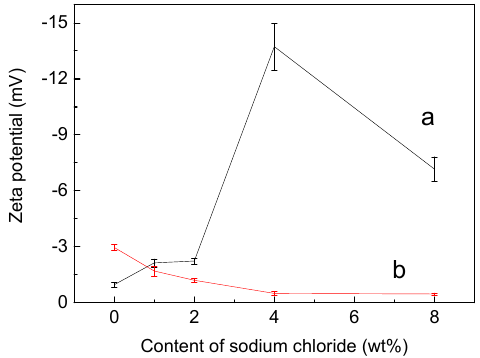
Figure 7. The Zeta potential of paraffin emulsion ( a ) and prepolymer solution ( b ).